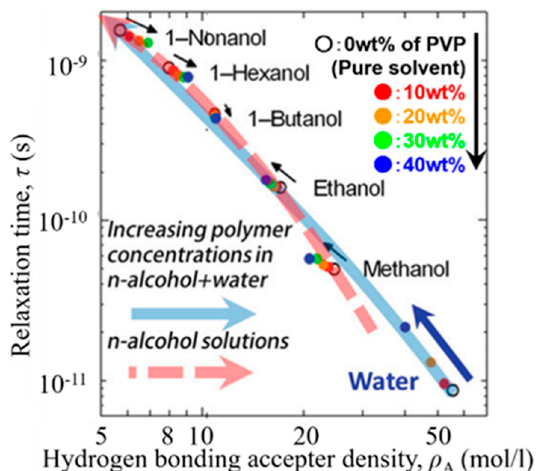
Figure 2. The relaxation time for solvent dynamics versus the HB acceptor density. The open circles indicate values for the pure solvents and closed circles were obtained for 10, 20, 30, 40, and 50 wt% PVP weight fraction. Small arrows indicate the direction of the trajectory with increasing polymer concentration for each solvent. The direction changes between 1-propanol and 1-butanol. Reproduced from Figure 8-4